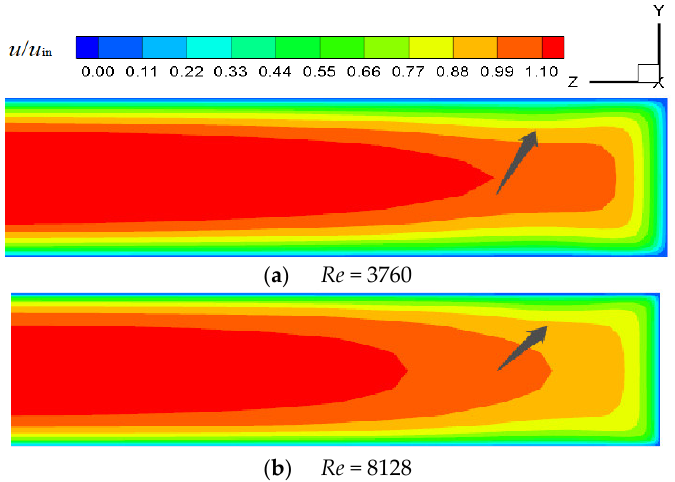
Figure 17. Nondimensional velocity magnitude contours on the middle cross section.